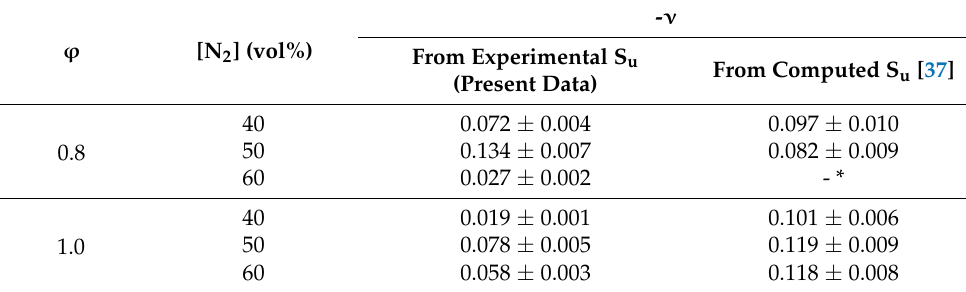
Table 4. The baric coefficients of laminar combustion velocities of the studied mixtures.